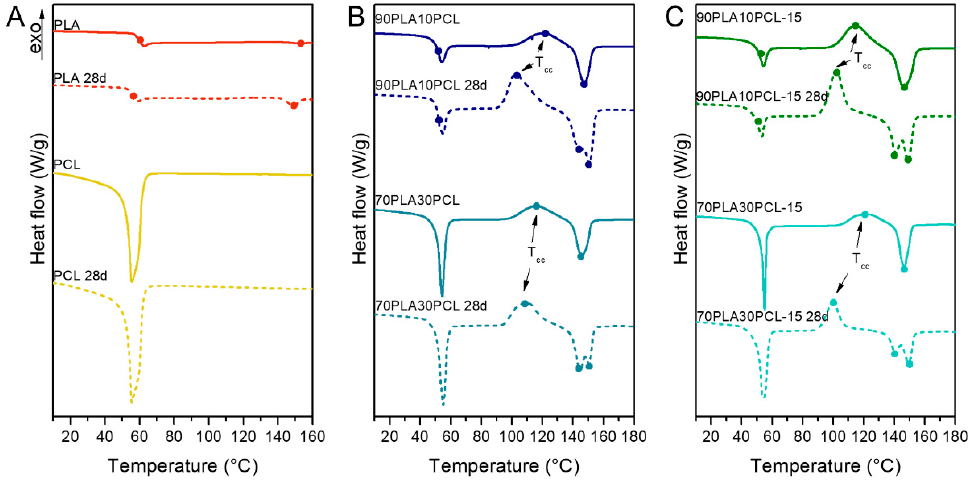
Figure 7. X-ray diffraction (XRD) data for neat samples (0 days) and after degradation (28 days); ( A ) pure polymers PLA and PCL, before and after degradation; ( B ) PLA/PCL blends before and after degradation; and ( C ) composite blends before and after degradation.